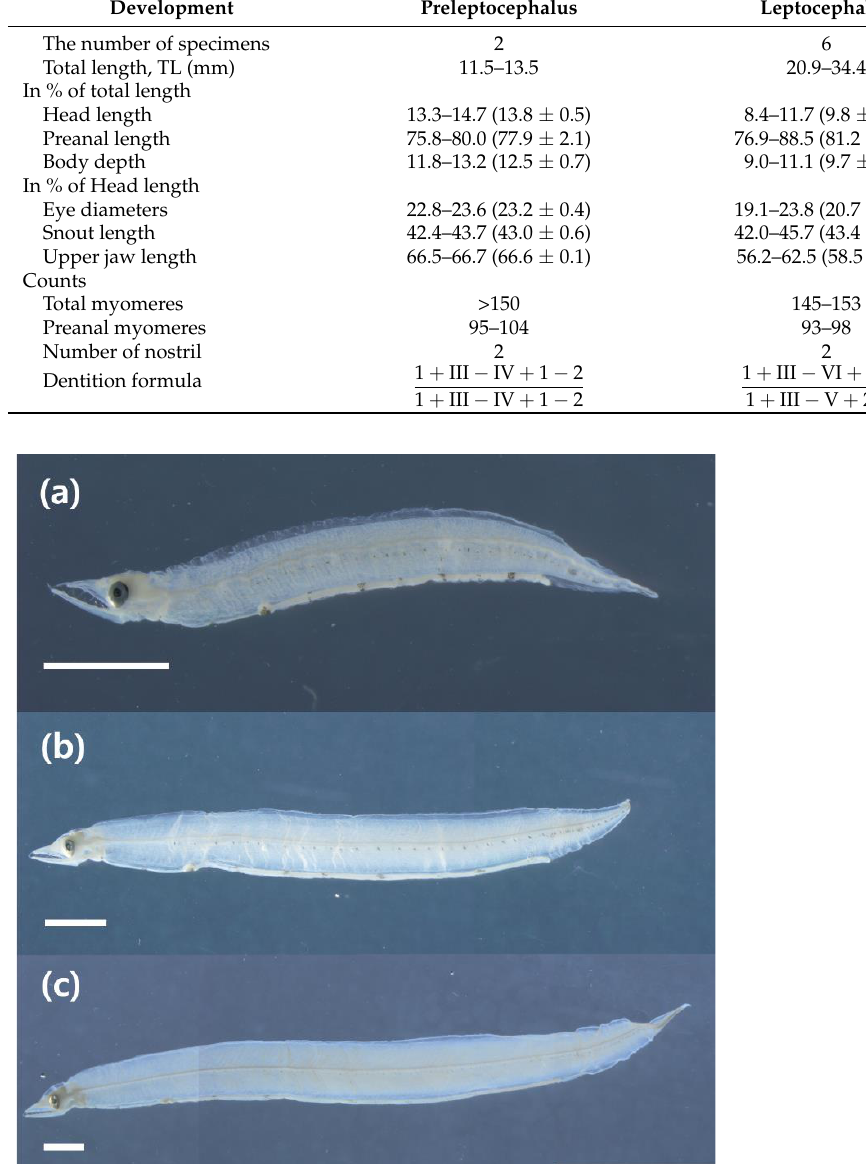
Figure 4. Photograph of preleptocephalus and leptocephali of M. cinereus collected from waters adjacent to Jeju Island: ( a ) preleptocephalus, total length (TL) = 11.5 mm, ( b ) leptocephalus, total length (TL) = 23.5 mm, ( c ) leptocephalus, total length (TL) = 34.4 mm Scale bars = 2.0 mm.